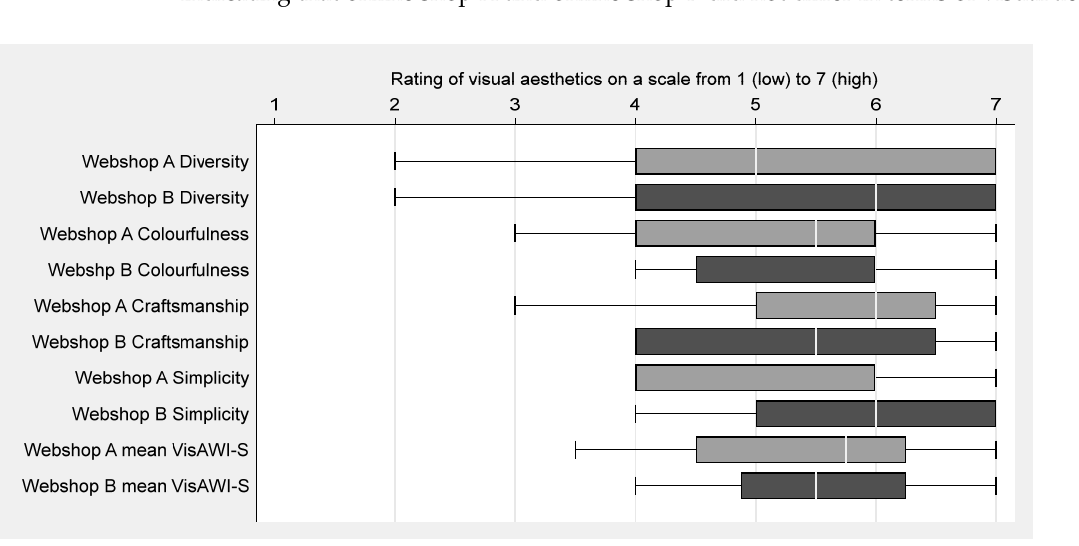
Figure 2. Assessment of visual aesthetics of the two online